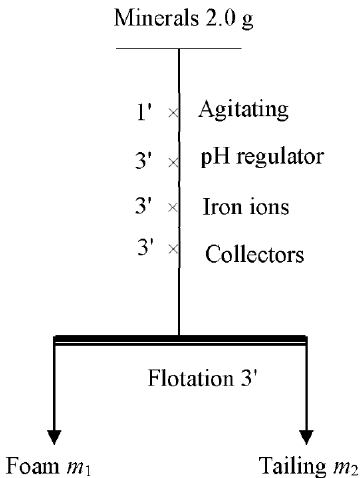
Figure 3. Flowsheet of single-mineral flotation tests.